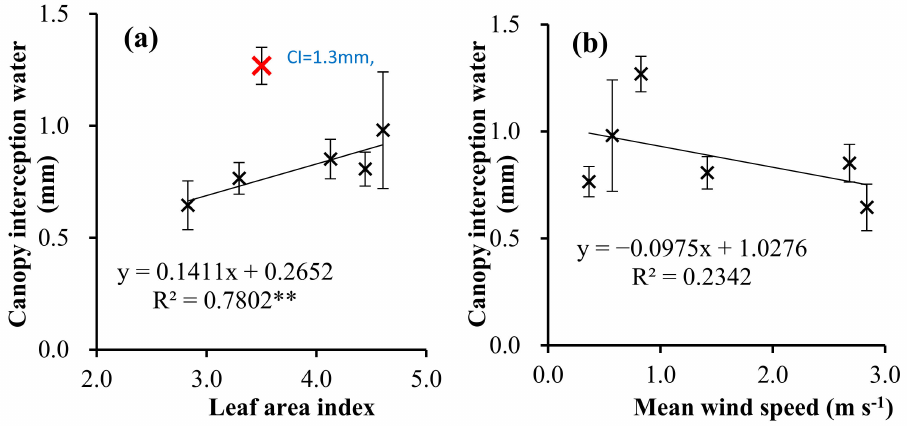
Figure 8. Relationships between canopy interception water and leaf area index ( a ) and wind speed during measurement ( b ). Symbol (**) after value of 0.7802 in ( a ) indicates this regression line is significant at 0.01